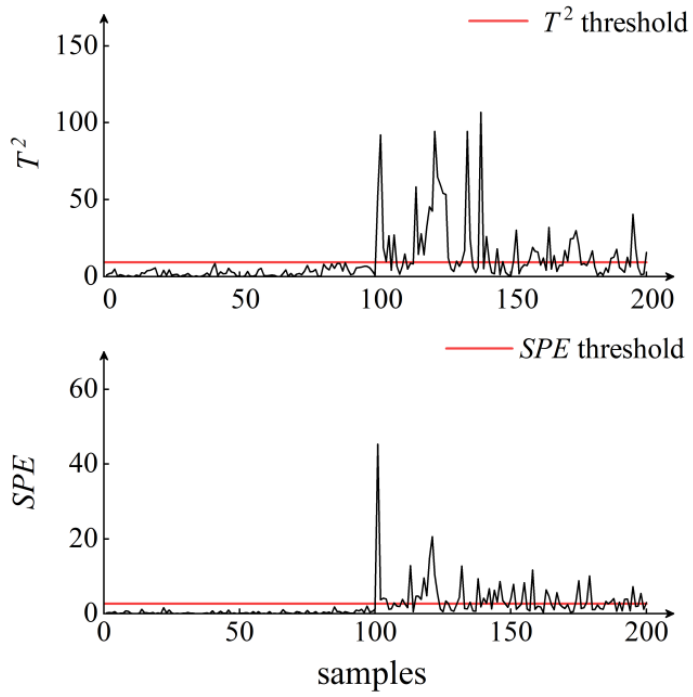
Figure 10. W-PLS monitoring of sample 1.